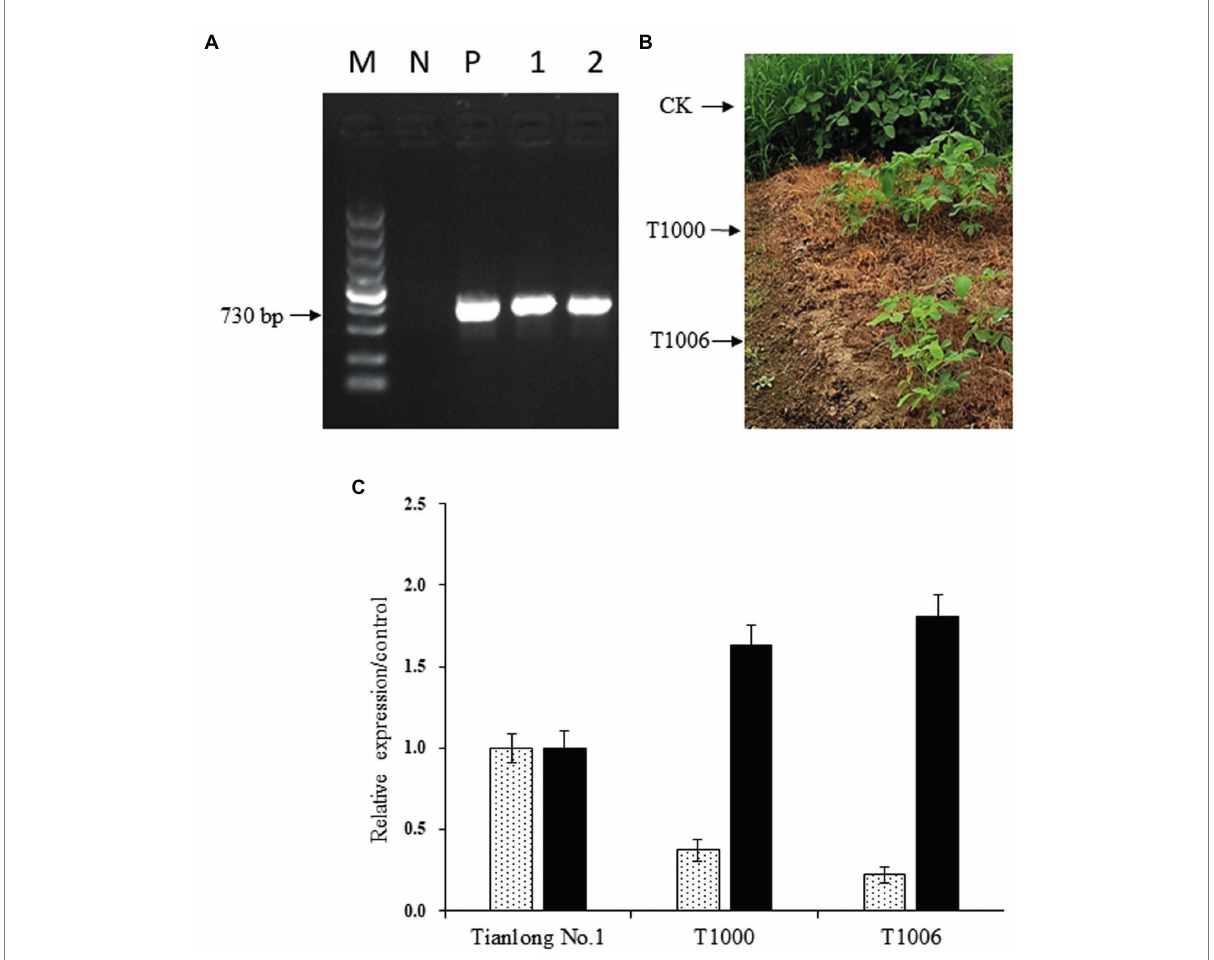
FIGURE 2 Expression of OsEPSPS, CG- β -1 and gy2 in transgenic soybean plants. (A) Detection of OsEPSPS transcripts by PCR amplification. M, DNA marker 5,000; N, the negative control ‘Tianlong No. 1’; P, the positive plasmid; Lane 1, T1000 transgenic lines; Lane 2, T1006 transgenic lines. (B) Glyphosate screening for transgenic lines. CK, ‘Tianlong No. 1’ without spraying glyphosate; T1000, T1000 transgenic lines sprayed with glyphosate (10 ml/l); T1006, T1006 transgenic lines sprayed with glyphosate (10 ml/l). (C) Detection of CG- β -1 and gy2 expression using quantitative real-time PCR. CK, T1000, and T1006 represent ‘Tianlong No. 1’, T1000, and T1006 transgenic plants, respectively, and the levels of CG- β -1 and gy2 measured in ‘Tianlong No. 1’ were regarded as the